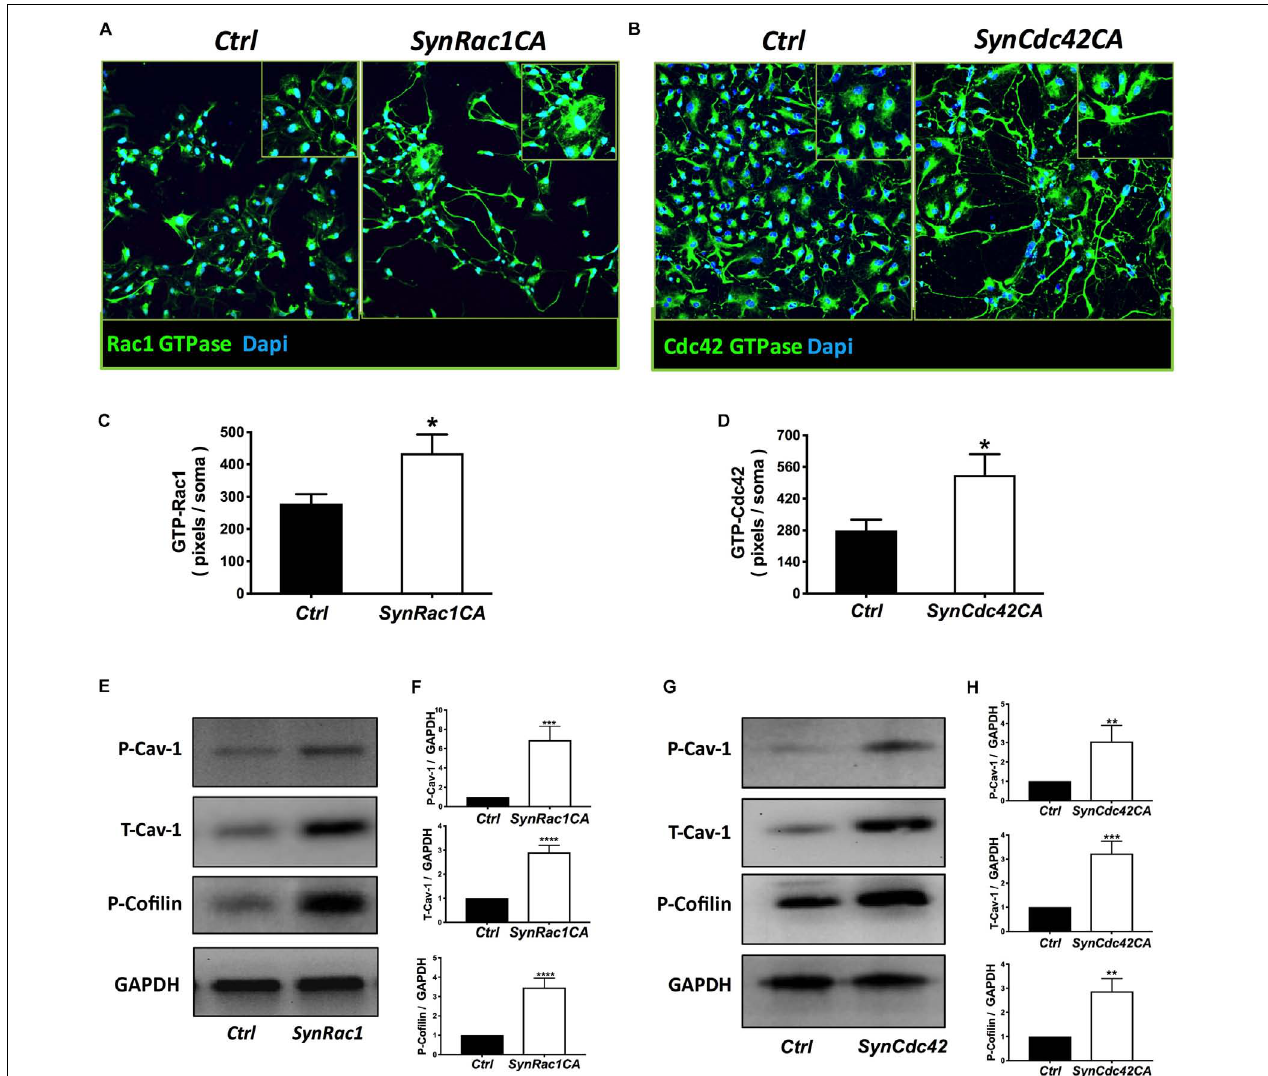
FIGURE 3 | Constitutively active (CA) Rac1 and Cdc42 enhance expression of P-Cav-1, T-Cav-1 and P-Cofilin. NPCs were treated with SynRac1CA or SynCdc42CA (2 × 10 9 IU/ µ l) and assayed for Rac1 GTPase (GTP-Rac1) (A) and Cdc42 GTPase (GTP-Cdc42) (B) , respectively. Quantitation of Rac1 GTPase (C) and Cdc42 GTPase (D) . Data are presented as total pixels (green) per soma (Dapi, blue). GTP-Rac1 (E) and GTP-Cdc42 (G) treated cell lysate were probed for P-Cav-1, T-Cav-1, and P-Cofilin ( F for GTP-Rac; H for GTP-Cdc42). Data are expressed as mean ± S.E ( n = 3, ∗ p < 0.05, ∗∗ p < 0.01, ∗∗∗ p < 0.001, ∗∗∗∗ p < 0.0001, One-way